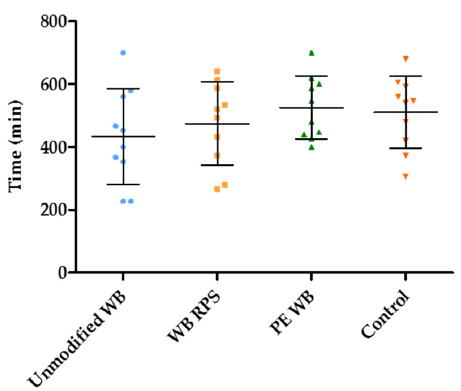
Figure 6. Wheat bran (WB) supplementation did not modify the duration of the fermentation ( n = 10). The middle line represents the mean with the standard deviation (whiskers).